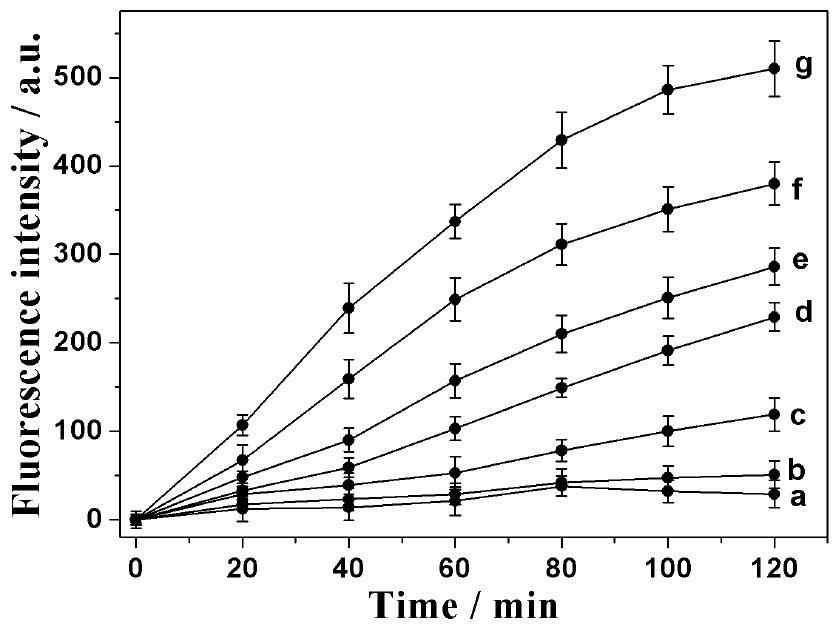
Figure 2. Fluorescence intensity of the proposed aptamer sensing with isothermal circular system containing the DNA aptamer (1 µ M), signaling probe (1 µ M), primer (2.5 µ M), dNTPs (2 mM), Klenow Fragment exo- (1 U/ µ L), and Nt.BbvCI (1 U/ µ L), and initiated with a different amount of the PDGF-BB sample (a: 0, b: 0.1 ng/mL, c: 1 ng/mL, d: 10 f ng/mL, e: 20 ng/mL, f: 40 ng/mL, g: 60 ng/mL) at different times.